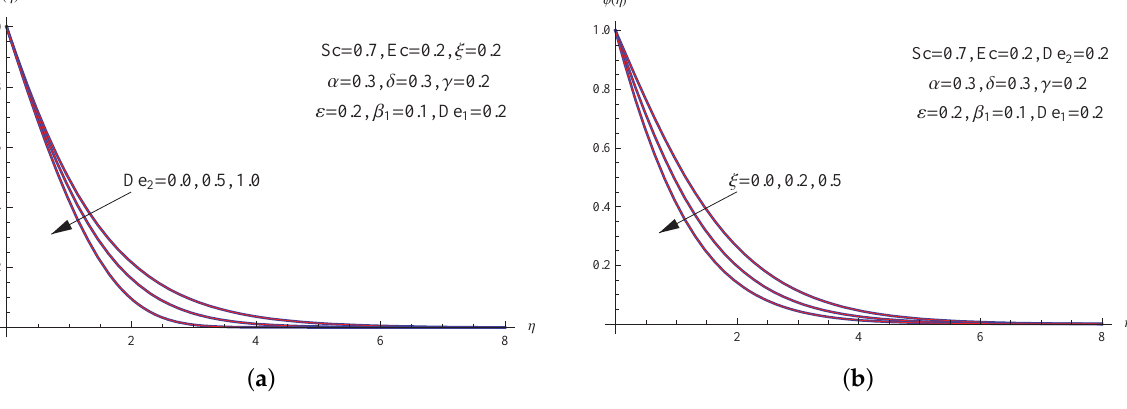
Figure 8. ( a ) φ ( η ) for picked De 2 . ( b ) φ ( η ) for picked ξ . The numerical outcomes for the local Nusselt number, the local Sherwood number, and the local skin-friction coefficient are displayed in Table 2 for different values of the arising parameters. From Table 2, it may be seen that because of an increment in the Powell–Eyring parameter α there is an expansion in the local skin-friction coefficient, the local Nusselt number, and the local Sherwood number, whereas the inverse pattern is noticed for the Powell–Eyring parameter δ . Additionally, from the same table, we note that the viscosity parameter decreases the local skin-friction coefficient, the local